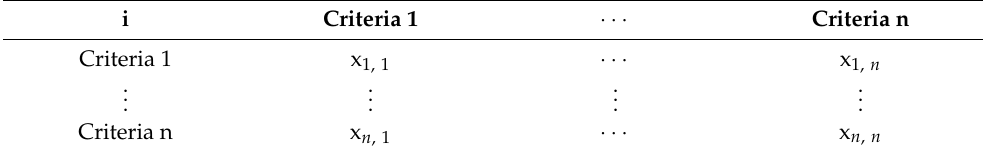
Table 3. Pairwise comparison of Criteria concerning the main